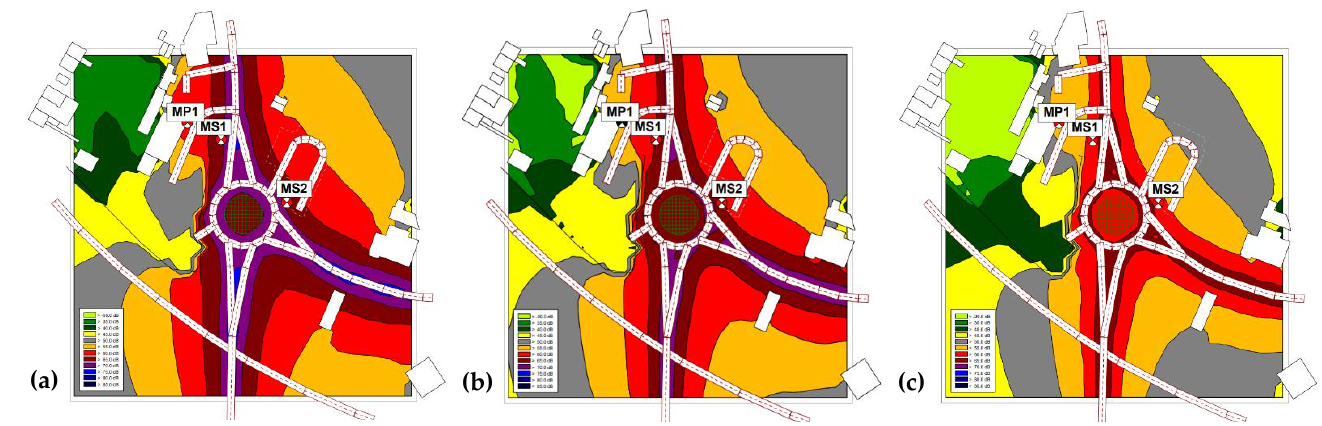
Figure 11. Model of the spreading of noise emissions from road traffic in the vicinity of the roundabout after 5 years of use in the city of Žilina (R_22) during the ( a ) daytime, ( b ) evening, and ( c ) night-time.